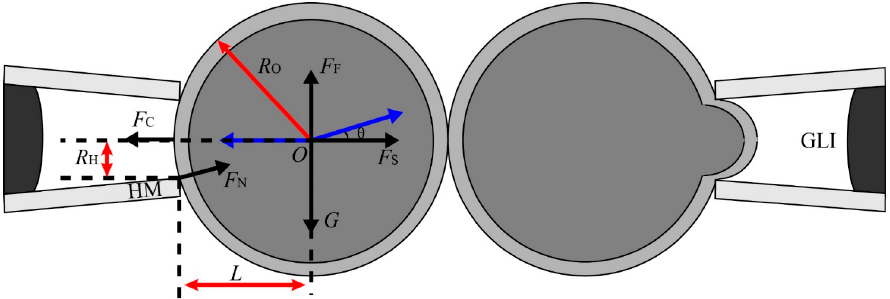
Figure 8. Diagram of force analysis in the calibration experiment.